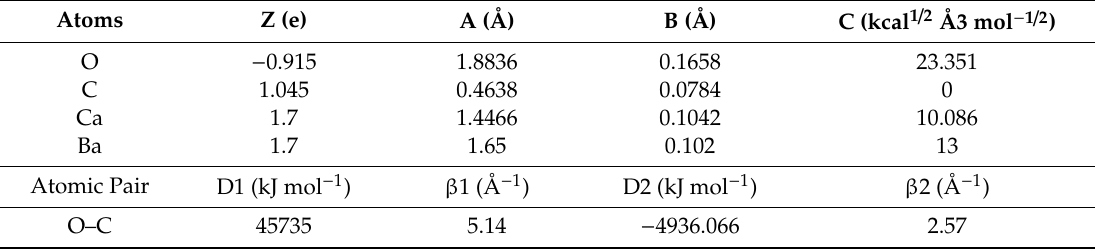
Table 1. Parameter sets for interatomic potential function for Molecular Dynamics (MD) simulations. Parameters for Ca, C, O, and O–C are from Kawano et al. [12]. Parameters for Ba was determined in this